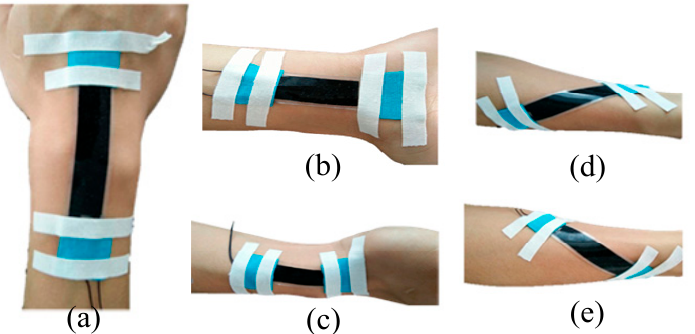
Figure 4. Single motion sensor placement: ( a ) Flexion; ( b ) Extension; ( c ) Ulnar deviation; ( d ) Pronation; ( e ) Supination.